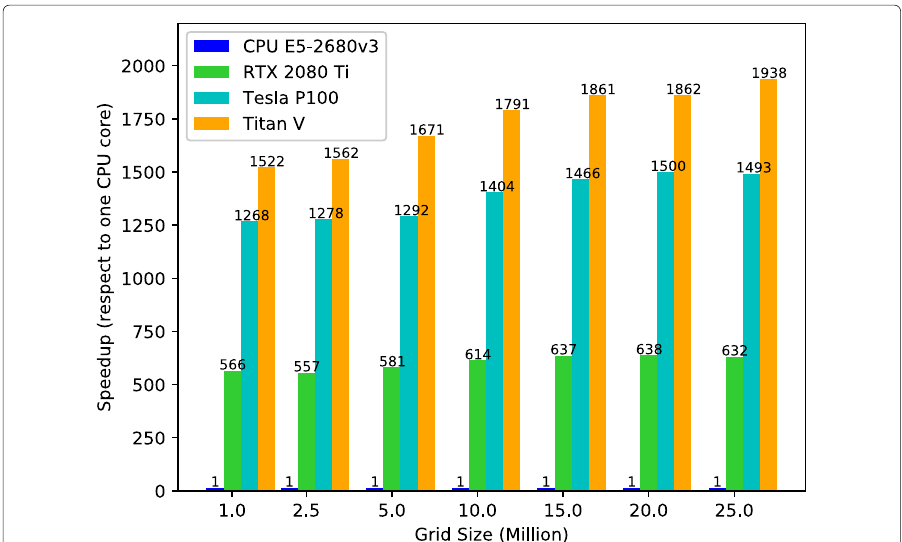
Fig. 13 Global performance varying with grid sizes. The speedup is defined as the ratio of elapsed time of running on CPU with one core to lapsed time of running with a GPU. The accelerating performance of three GPUs is in agreement with their DP performance (see Table 1). Titan V gets the highest speedup, due to maximum number of CUDA cores and maximum number of double precision processing units. Although RTX 2080 Ti has more CUDA cores than Tesla P100, it has less double precision processing units than Tesla P100. When the grid size increases, speedups of the three GPUs increase in general. But Titan V and Tesla P100 get higher increments. When the grid size is larger than 15 million, Tesla P100 and RTX 2080 Ti almost reach their limits, while there is space for Titan